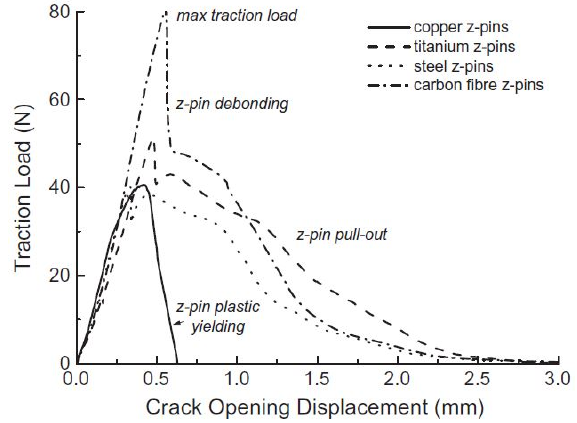
Figure 25. E ff ect of z-Pin material on mode I z-Pin response (d = 0.51 mm, 2.0 vol%, t = 4